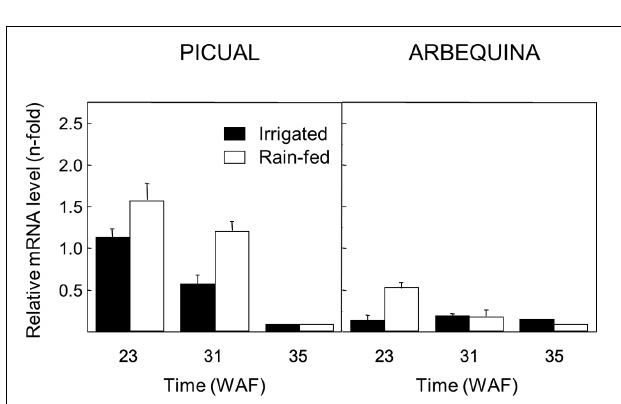
FIGURE 7 | Effect of the water regime on the relative expression levels of the olive GLU gene in the Picual and Arbequina mesocarp tissues from olive trees cultivated with natural rainfall or